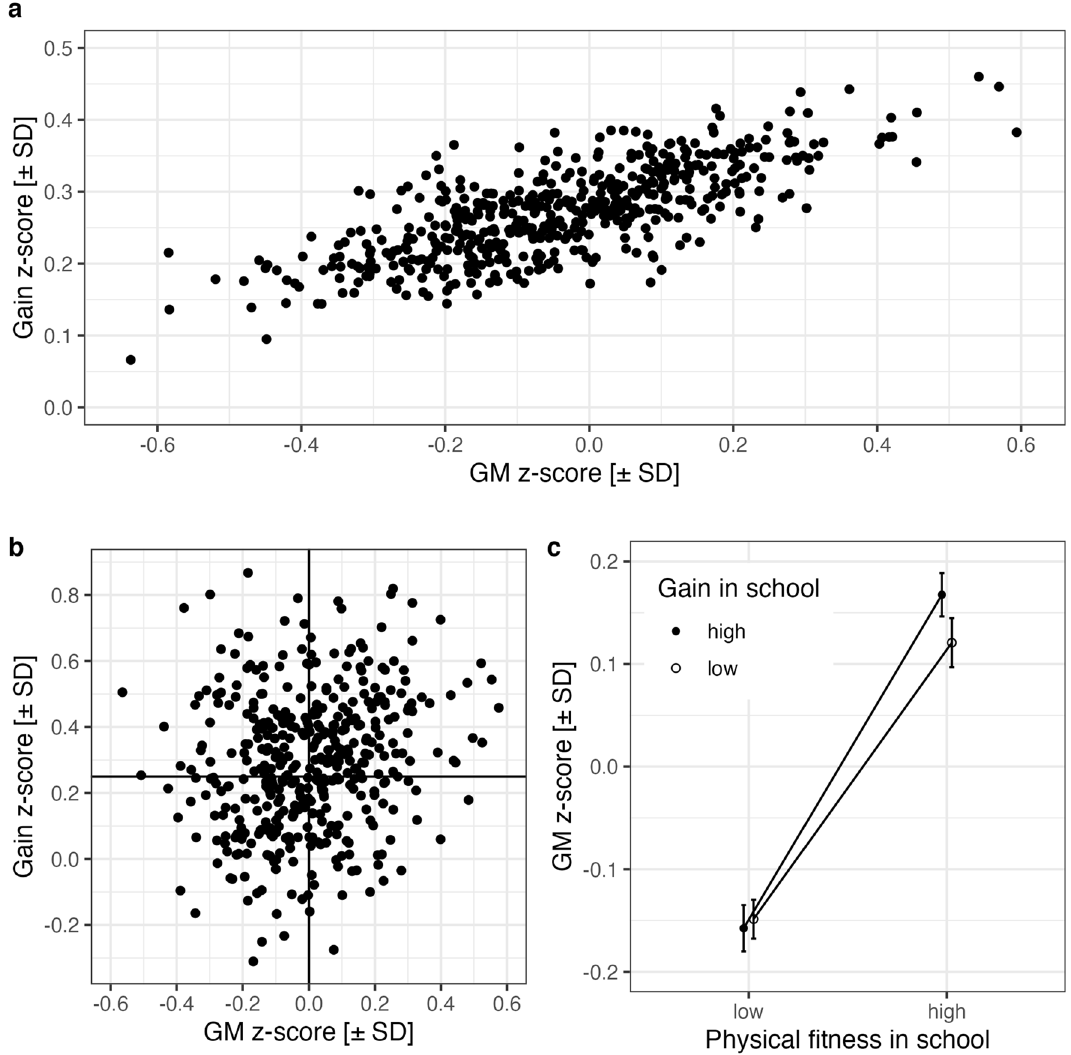
Figure 3. ( a ) Visualization of correlation parameter between Grand Mean (GM) and yearly gains (age effect) of 515 schools using conditional means resulting from shrinkage correction of observed data with LMM parameters. ( b ) Scatterplot of observed GMs and yearly gains (within-school age slopes) for 421 schools reporting data from more than 30 boys and 30 girls. ( c ) After sorting schools into groups of high vs. low physical fitness (split at 0) and high vs. small gain-rate (split at the gain of + 0.25), the interaction corresponding to the CP becomes visible; error bars are 95% CIs. SD = standard